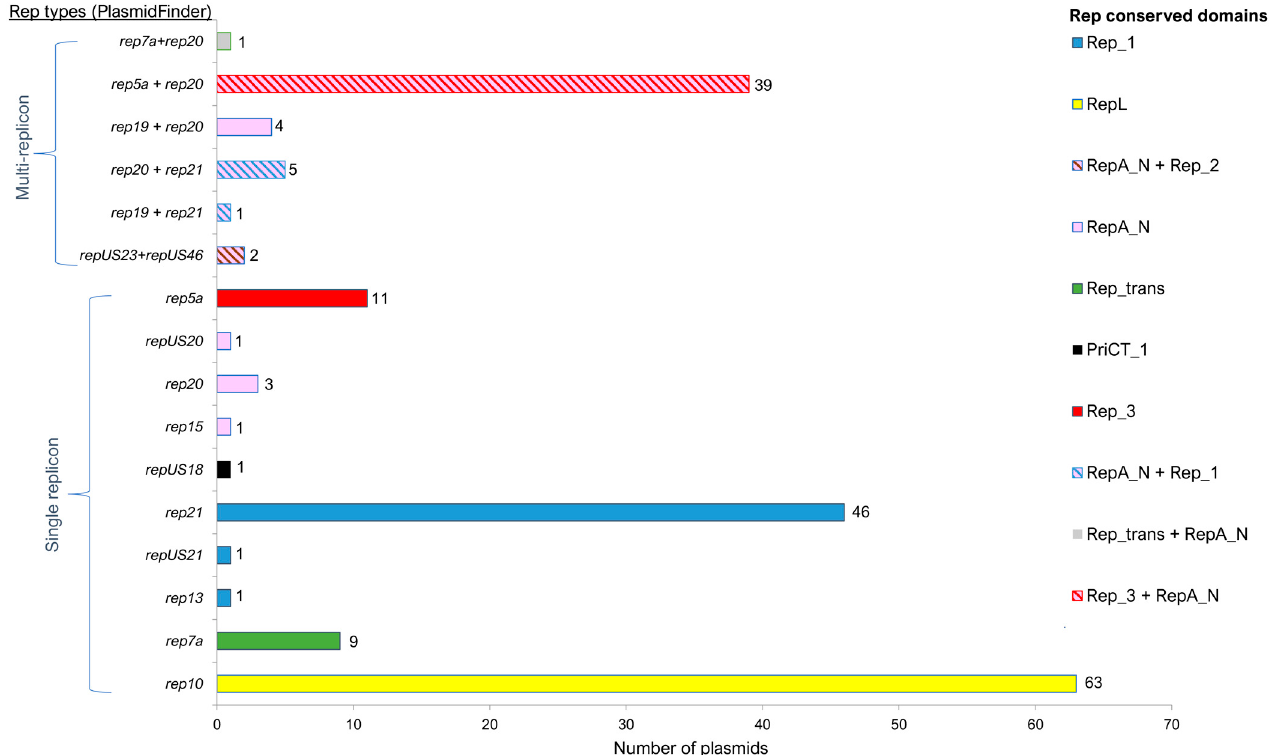
Figure 2. Distribution of replicon types in the plasmids identified from the sequenced MRSA isolates from Malaysia. The rep types were identified by the scheme proposed by Jensen et al. [43] and Lozano et al. [44] and available in PlasmidFinder (https://cge.food.dtu.dk/services/PlasmidFinder/, accessed on 1 January 2022). The replication initiation proteins (replicases) were also grouped by their conserved domains [42]. Multi-replicon plasmids encode more than one full-length rep gene whereas single-replicon plasmids only encode one full-length rep gene.